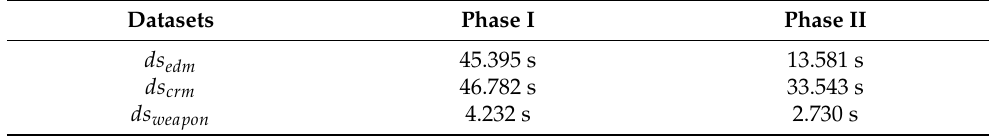
Table 5. Average running time of our method on ds edm , ds crm and ds weapon